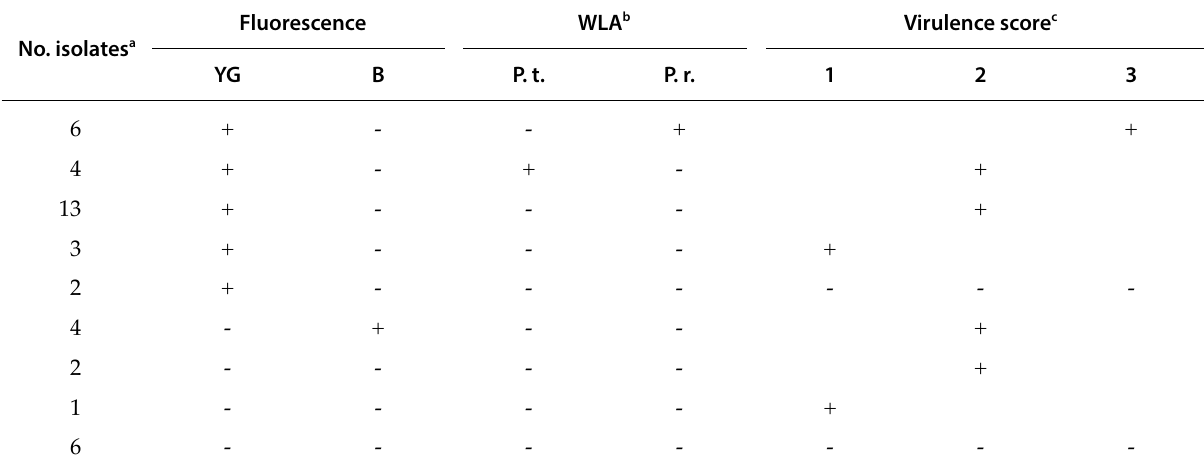
Table 2. Features of the bacterial isolates obtained from superficial yellowish lesions present on Pleurotus ostreatus sporo-